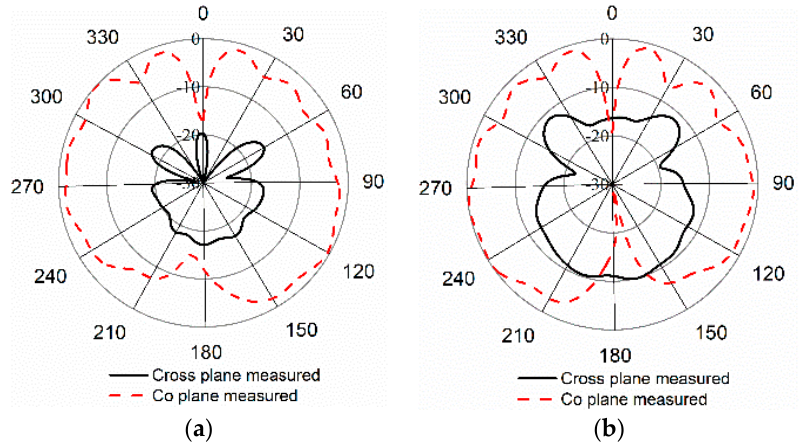
Figure 9. Normalized radiation patterns of the proposed antenna at ( a ) Phi 0; ( b ) Phi 90.